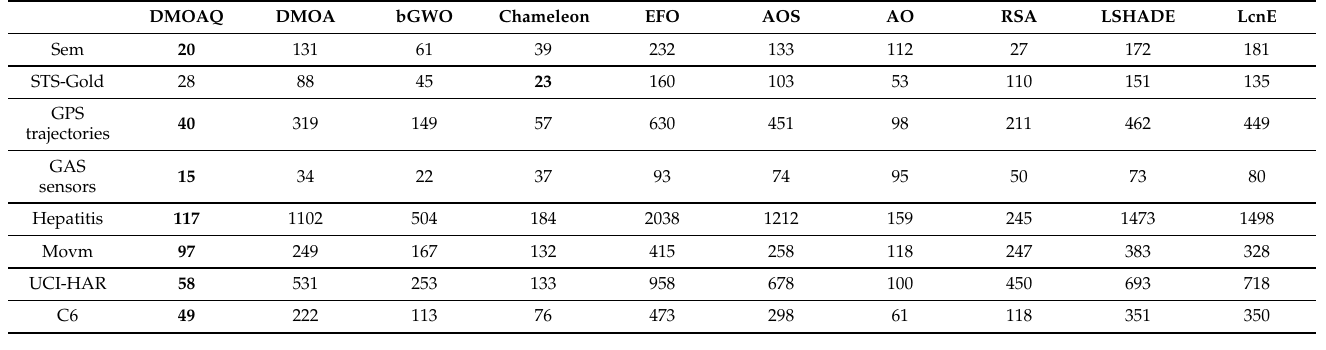
Figure 7. Average of the fitness function values. Table 10. Number of selected features obtained from competitive algorithms.